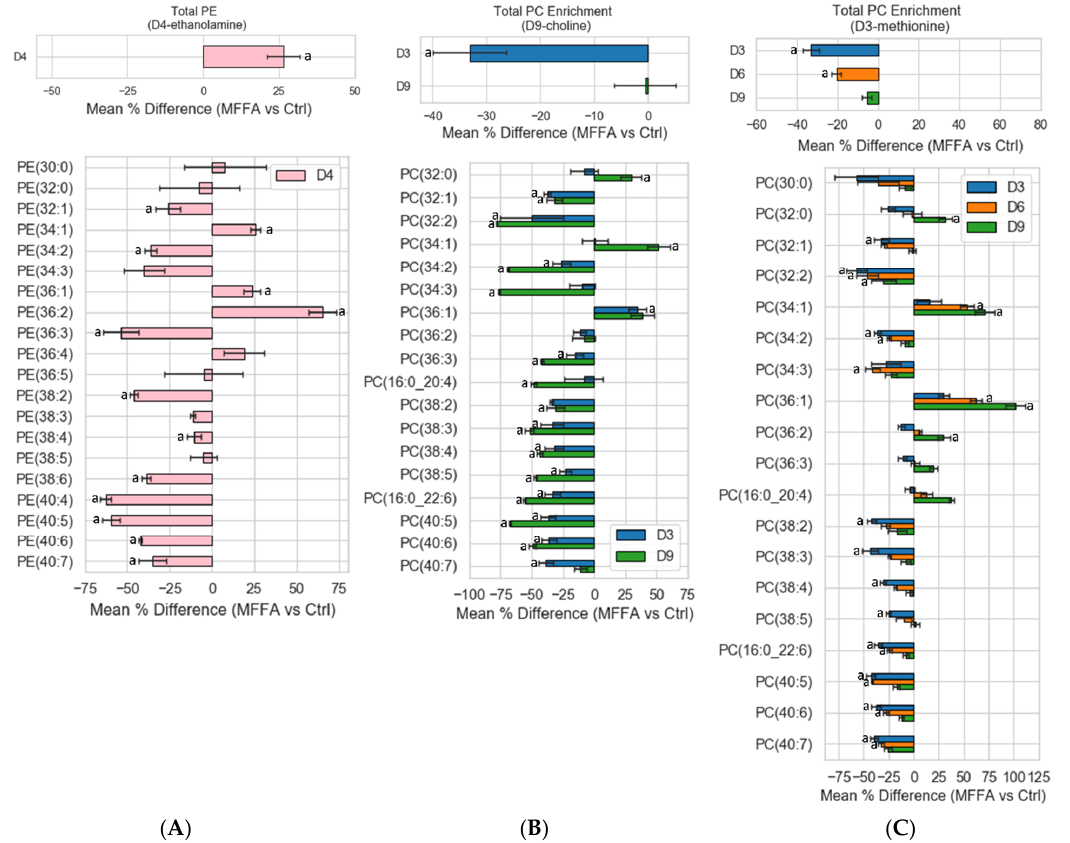
Figure 5. Differences in isotopic-labeled lipid enrichments between control and MFFA-treated hepatocytes. Isolated rat hepatocytes were treated without (Ctrl) or with 2 mM of MFFA in special DMEM media of which a nutrient has been replaced with its deuterated version (50 μM D4-ethanolamine, 30 μM D9-choline, or 200 μM D3-methionine), serving as a flux tracer for phospholipid biosynthetic pathways. The cells were then harvested after 6 h. Mean percentage differences in enrichment values of the deuterated PE for D4-ethanolamine ( A ) and deuterated PC for D9-choline ( B ) and D3-methionine ( C ) experiments are shown. Phospholipid species with very low abundances which made the calculation of enrichments and mean % differences impossible or unreasonable (0 as denominator of the ratio or differences by several hundred folds) were excluded (a: p < 0.05 Ctrl vs. MFFA enrichments, Mann–Whitney U test; n = 4 for D4-ethanolamine experiments; n = 3 for D9-choline and D3-methionine